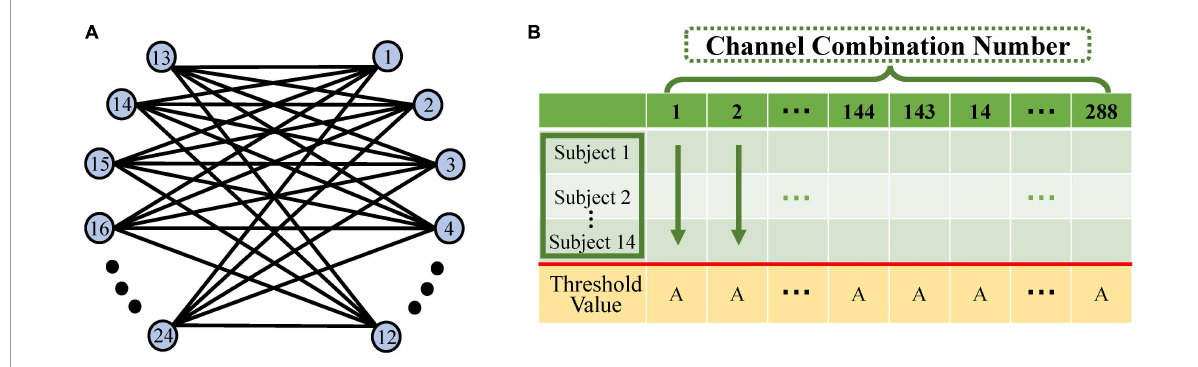
FIGURE4 Schematic diagram of causal network computation. (A) The left–right hemisphere heterotopic connectivity model: blue circles indicate the 12 fNIRS channels on the left- and right-brain. Each channel in the left brain is connected to each in the right brain in both directions, resulting in 288 (12 × 12 × 2) channel combination pairs. (B) Schematic diagram of the calculation of significant channel pairs: horizontal coordinates indicate the 288 channel pairs in this table. Each column consists of the Granger causality (GC) values under a single task for 14 subjects. We calculated the significant difference between the 14 GC values and the threshold for each channel pair. Of the 288 channel pairs, those significantly greater than that threshold were screened out and used to construct the causal network.